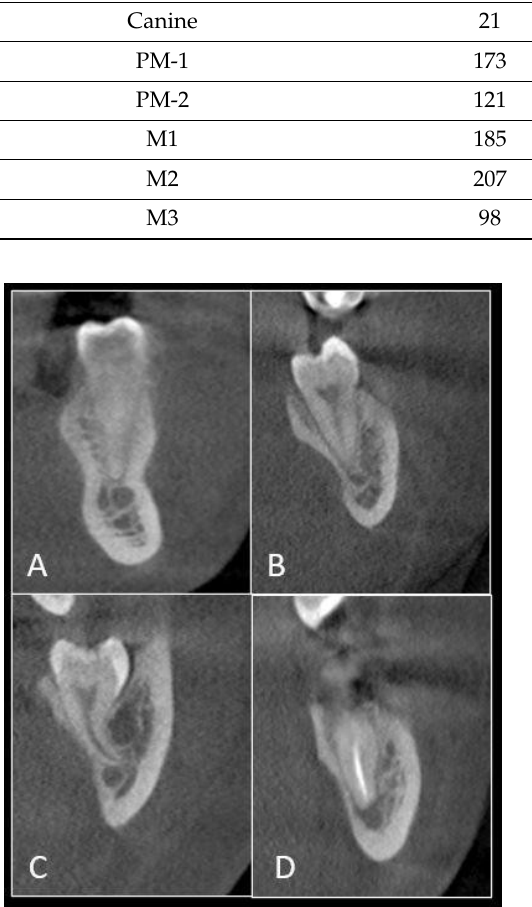
Table 2. Number (n) and percentage (%) of cases with DC of IAC to the apex of the root.